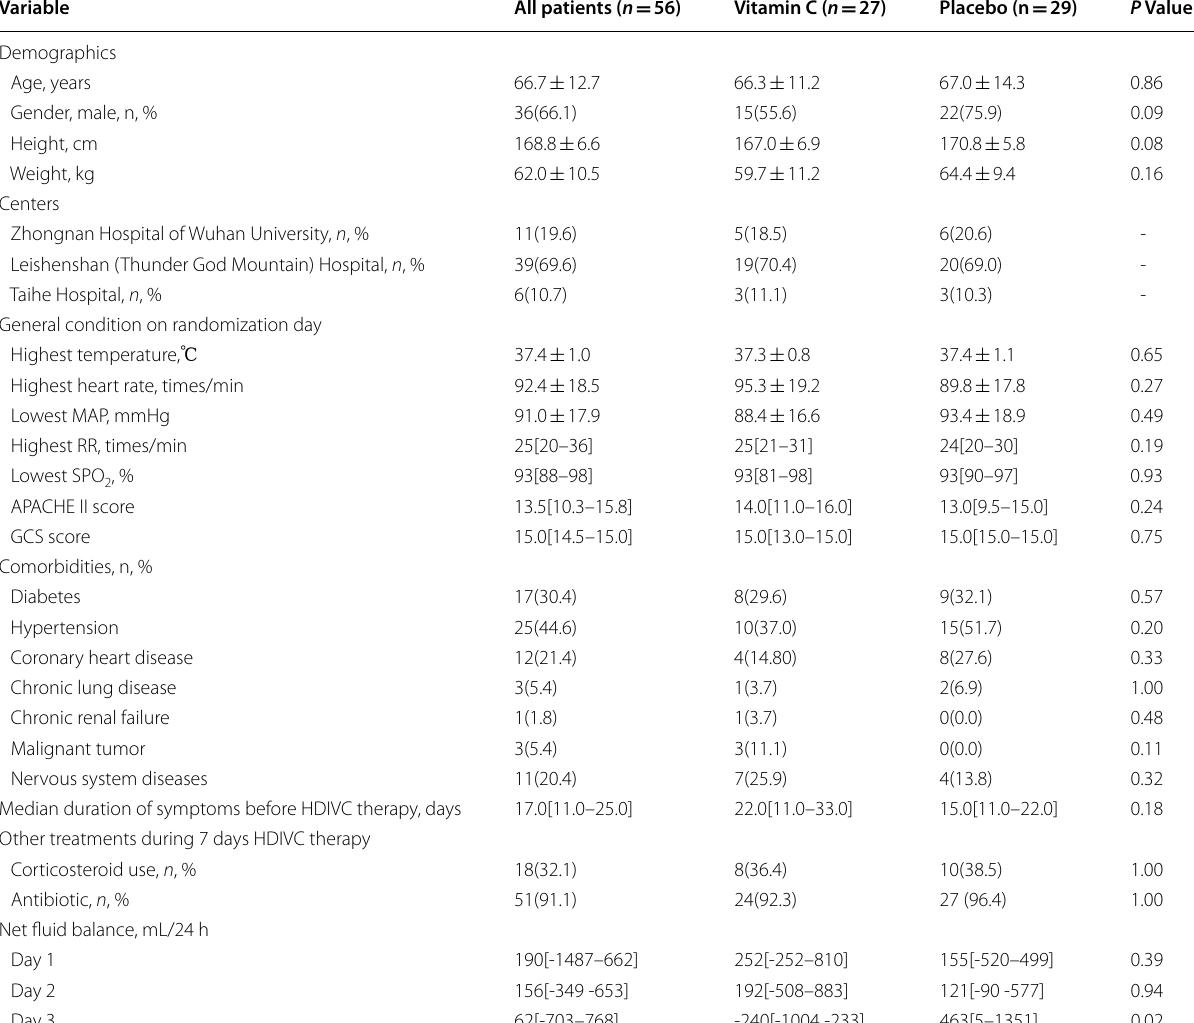
Table 1 Baseline characteristics of intention-to-treat patients